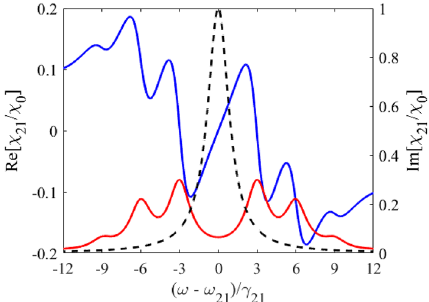
Figure 2. (Color online) Absorption (red curve, right axis) and dispersion (blue curve, left axis) of the vibrating resonant absorber at the frequency of the monochromatic field, ω , according to Eq. (15) in the laboratory 2.4 and � 3 . The black dashed curve (right axis) is the absorption line of γ 21 p 1 reference frame for p = = = 0 . The black dashed curve here also represents the motionless absorber plotted according to Eq. (15) for p 1 = (cid:31) γ 21 the incident wave packet with Lorentz spectrum of the HWHM � =